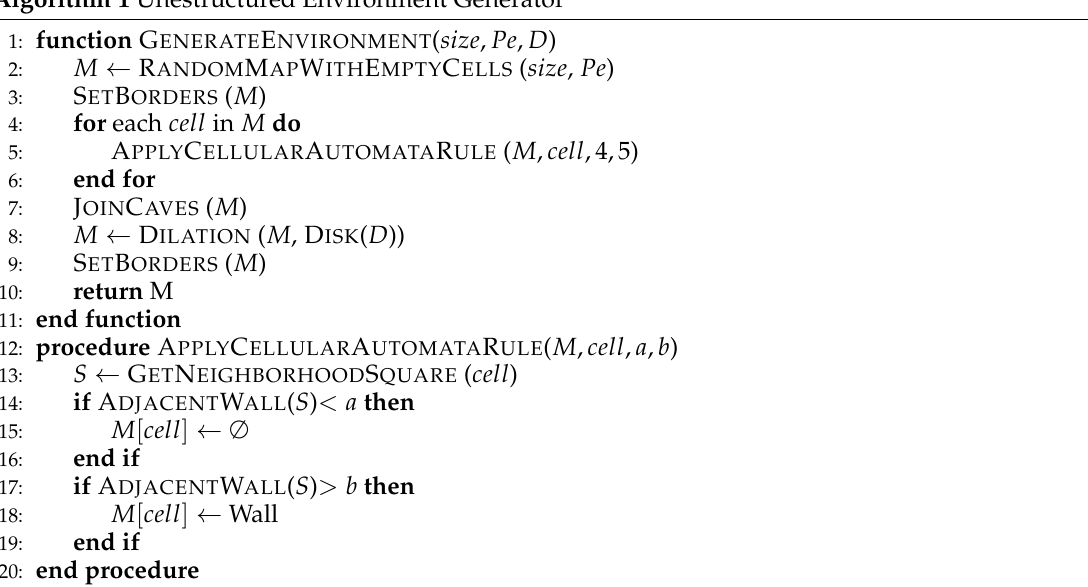
Algorithm 1 Unestructured Environment Generator